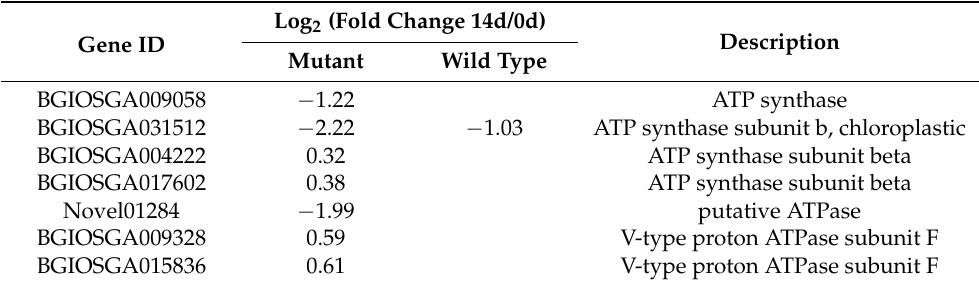
Table 5. Genotypic differences in expressions of DEGs associated with ATPase between the initial and 14th day of the grain-filling stage (padj < 0.05).